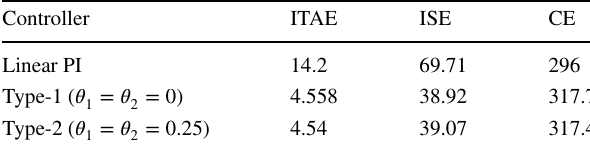
Table 9 Performance indices for tracking response (DCM)